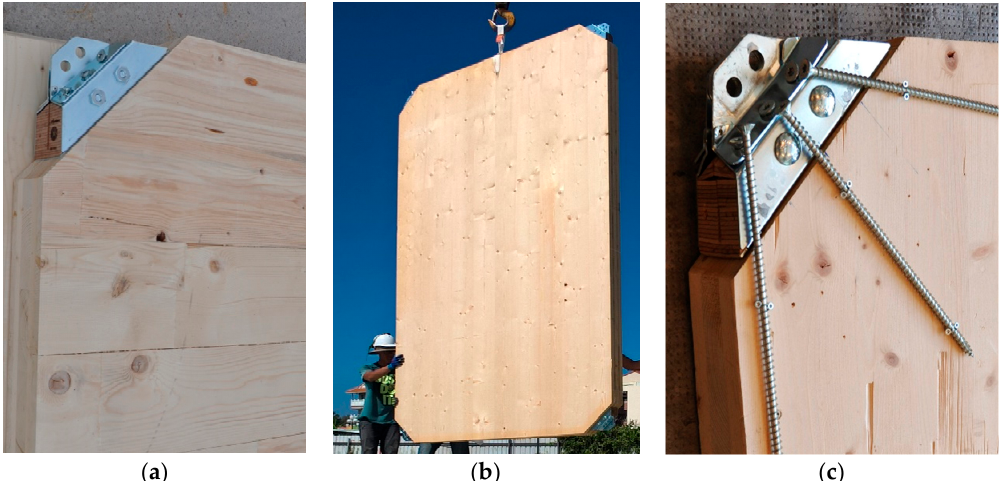
Figure 1. ( a ) X-Rad connector installed at one corner of a cross-laminated timber (CLT) panel; ( b ) CLT